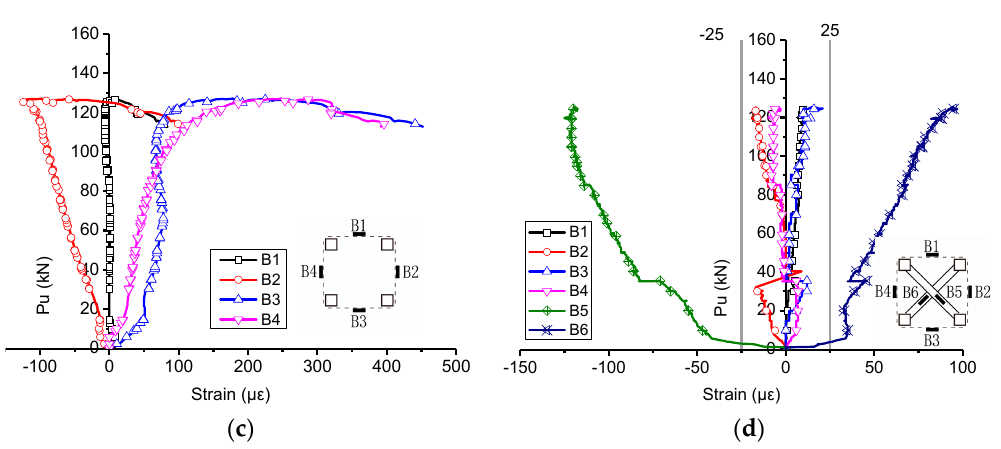
Figure 7. Load-strain curves of connectors: ( a ) S1; ( b ) S2; ( c ) S3; ( d ) S4.